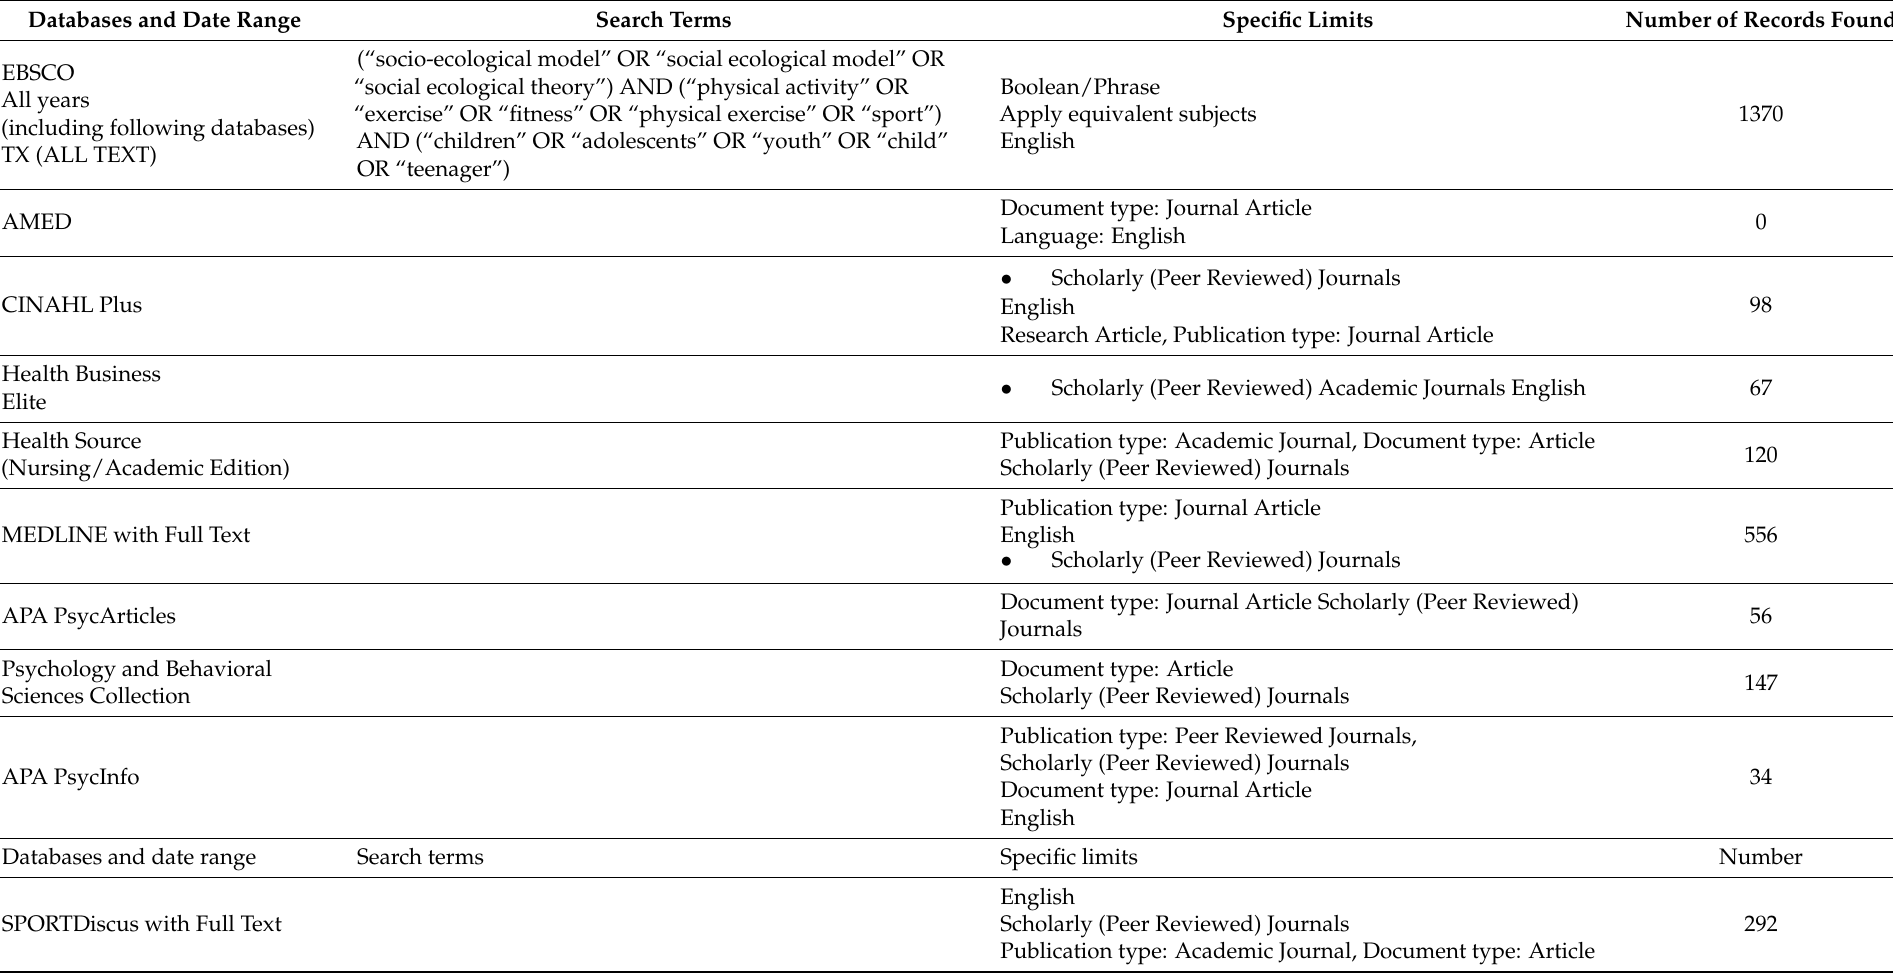
Table A1. Literature search